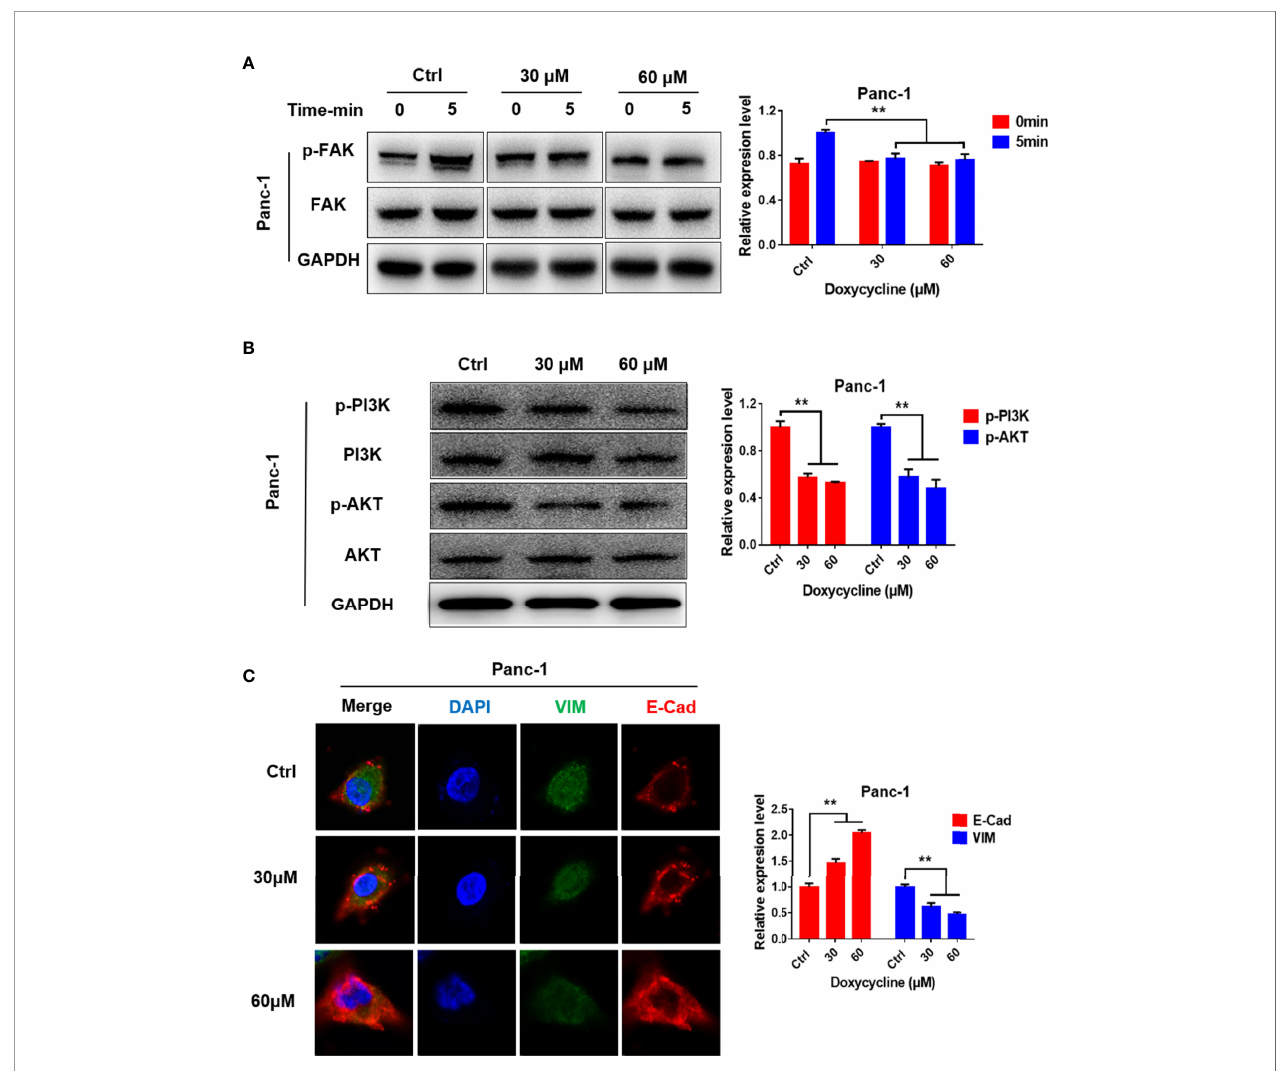
FIGURE 6 | Doxycycline inhibits the FAK/PI3K/AKT signaling pathways. (A) Panc-1 cells were treated with doxycycline and stimulated by thrombin for indicated time intervals, and the FAK phosphorylation changes were detected by Western blot analysis. (B) Effect of doxycycline on PI3K and AKT phosphorylation in Panc-1 cells detected by Western blot analysis. (C) Effect of doxycycline on the E-Cad and VIM expression levels in Panc-1 cells. Data are shown as the mean ± SD (** P <